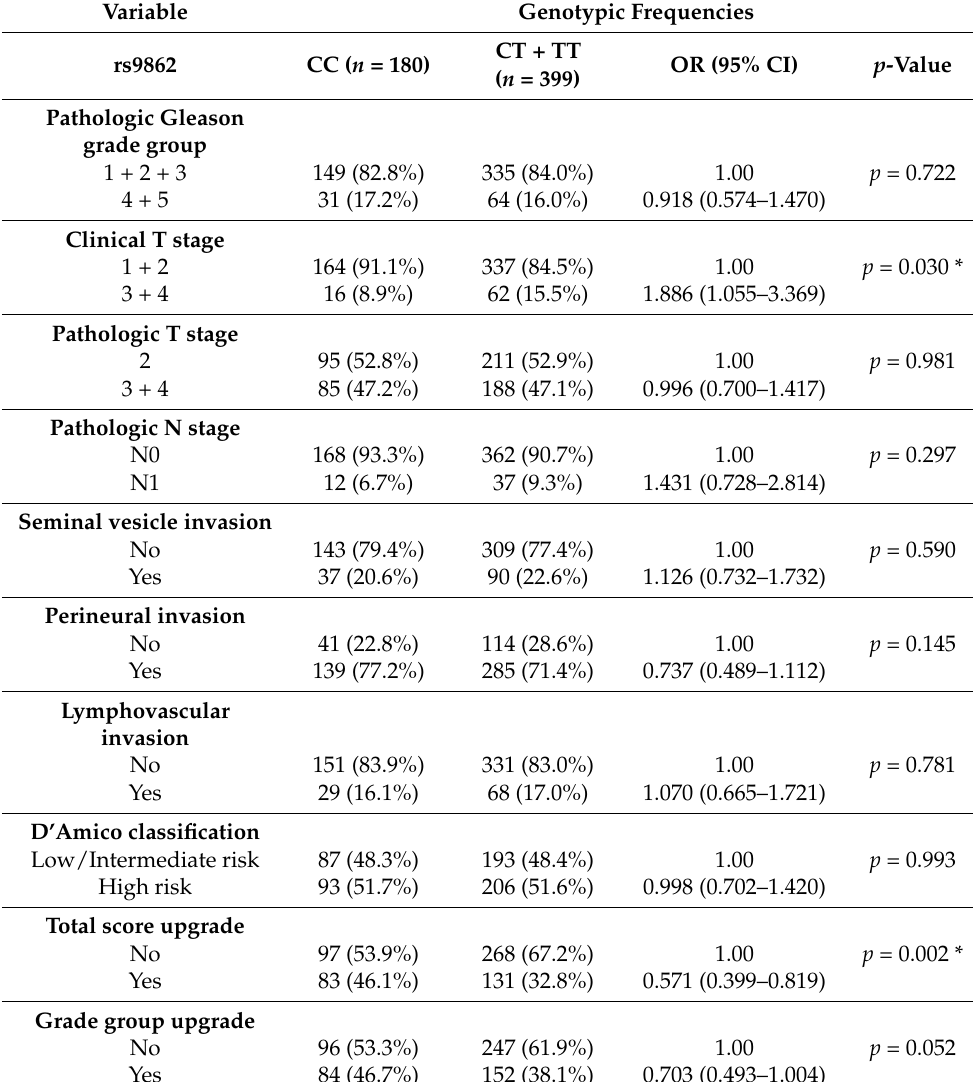
Table 5. Odds ratios (OR) and 95% confidence intervals (CI) of the clinical status and TIMP3 rs9862 genotypic frequencies in 579 patients with prostate cancer.